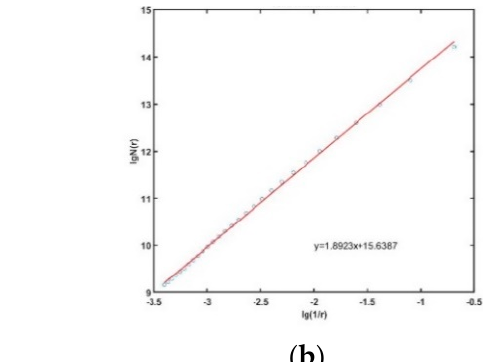
Figure 17. The damage picture of the center of the arch by impact (30 kg) and burning ( a ); the fractual curve ( b ).